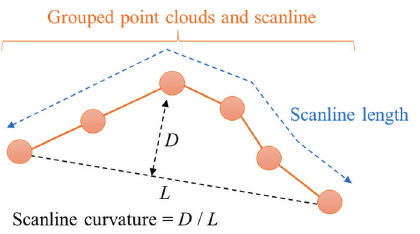
Figure 2 . Image of scanline length and scanline curvature